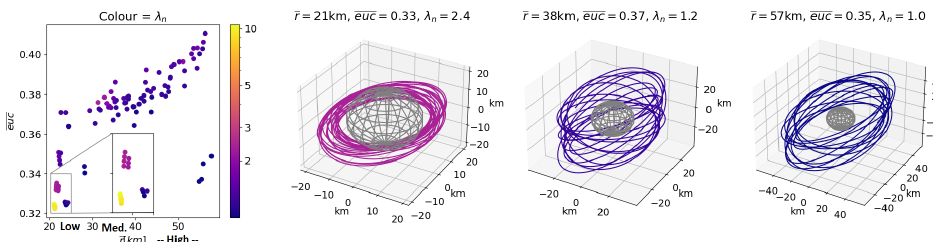
Figure 1. Pareto Front for the non-dominated objective space of proximity, coverage, and stability. Three sample trajectories (low, medium, and high) are plotted in the BFF. The motion is retrograde (clockwise) to curtail the destabilising effect of the C 22 term which is “averaged out” in space due to the large relative angular motion between the spacecraft and Phobos